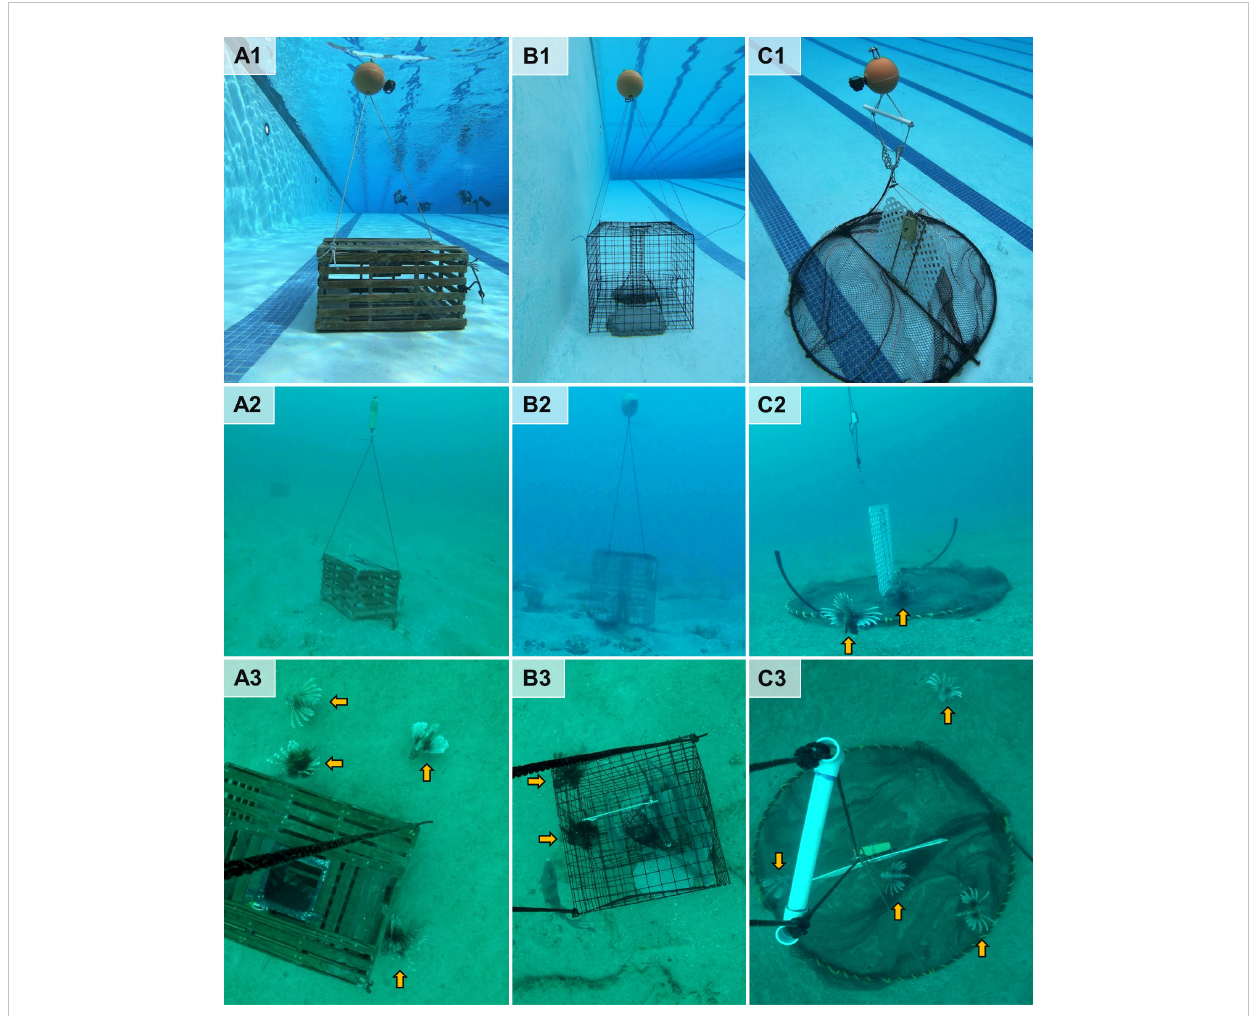
FIGURE 1 Experimental traps tested for catching invasive lion fi sh. Trap designs included (A) wooden slat traps used in the Florida spiny lobster fi shery, (B) wire mesh traps used in the South Atlantic sea bass fi shery, and (C) Gittings non-containment lion fi sh traps. Traps were gear tested in the University of Florida pool ( fi rst row) before the study ’ s experimental deployments near northeastern Gulf of Mexico mesophotic reefs (second row; images from a remotely operated vehicle). A subset of traps were monitored with remote time-lapse cameras from a subsurface buoy above the trap (third row). Photos by the